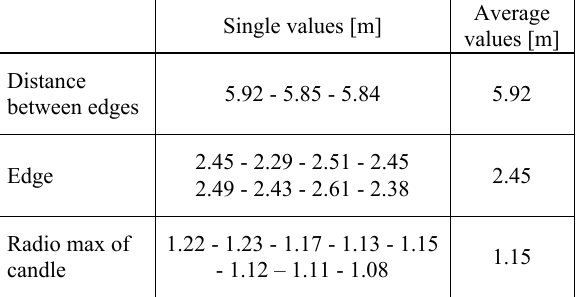
Table 2. Average calculations of the